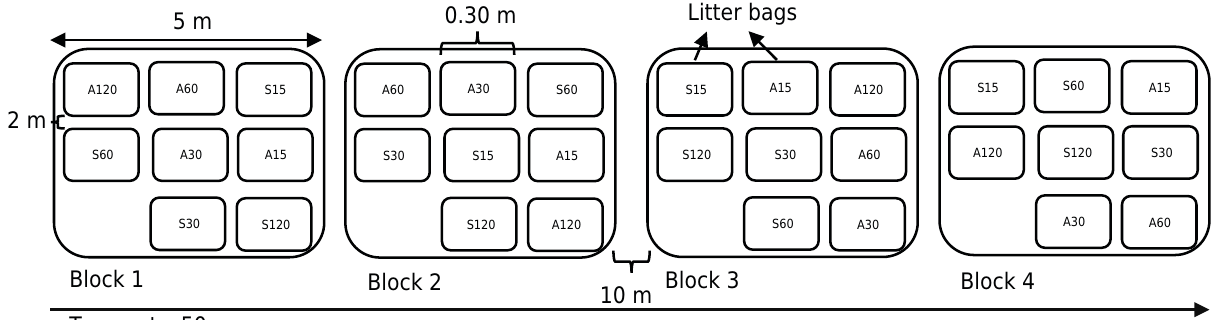
Figure 1. Experimental design showing the four blocks in each sampling site and the arrangement of the 32 litter bags of each leaf-litter species inside the blocks. The letters A and S inside the litter bags correspond to Schinus terebinthifolius and Senna multijuga , respectively. The numbers that follow indicate the number of days of exposure for sampling purposes (15, 30, 60, and